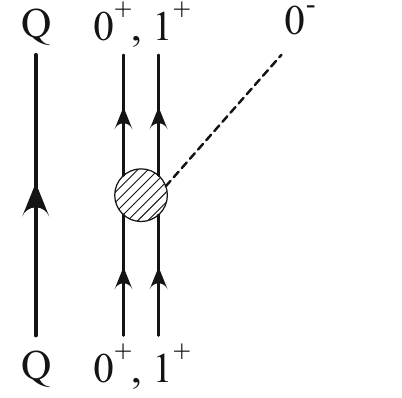
Fig. 5 Light diquark